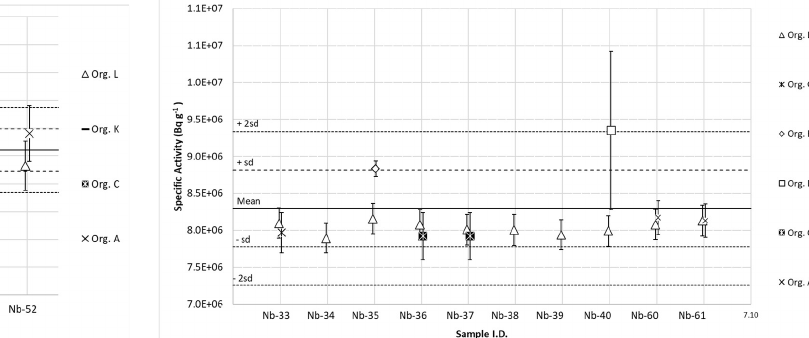
Fig. 5 93m Nb Specific activity measurements obtained for B.5, 8mg disk with 0.3 ppm Ta